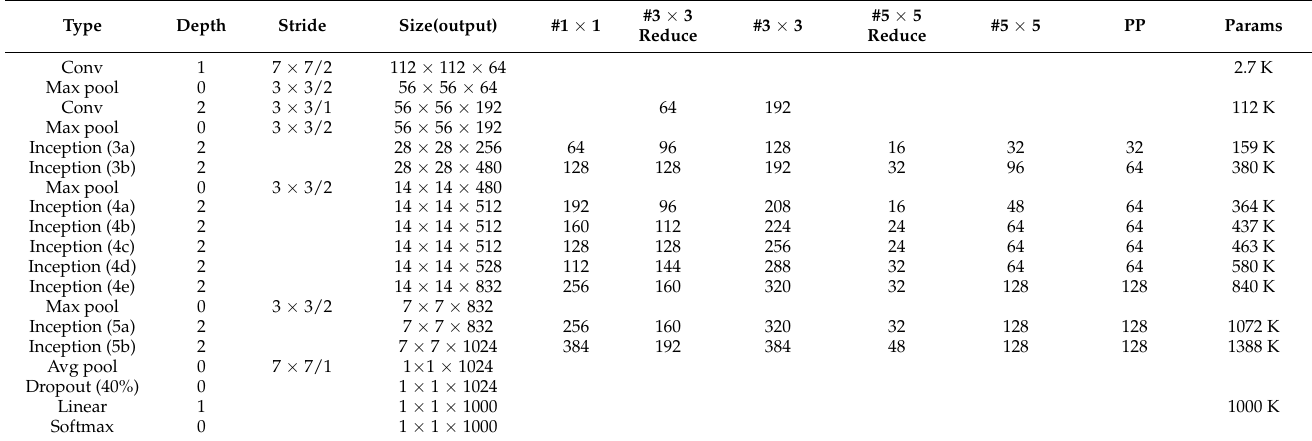
Table 3. The network structure of